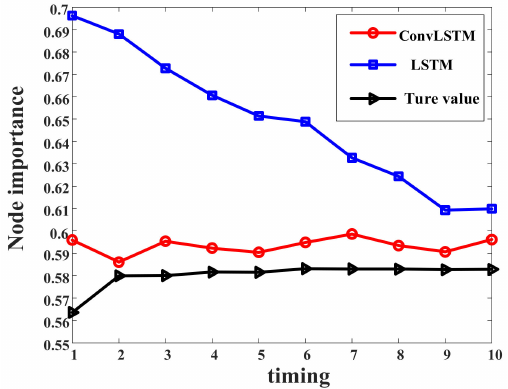
Figure 9. Comparison of prediction values of node importance of IEEE-118 bus